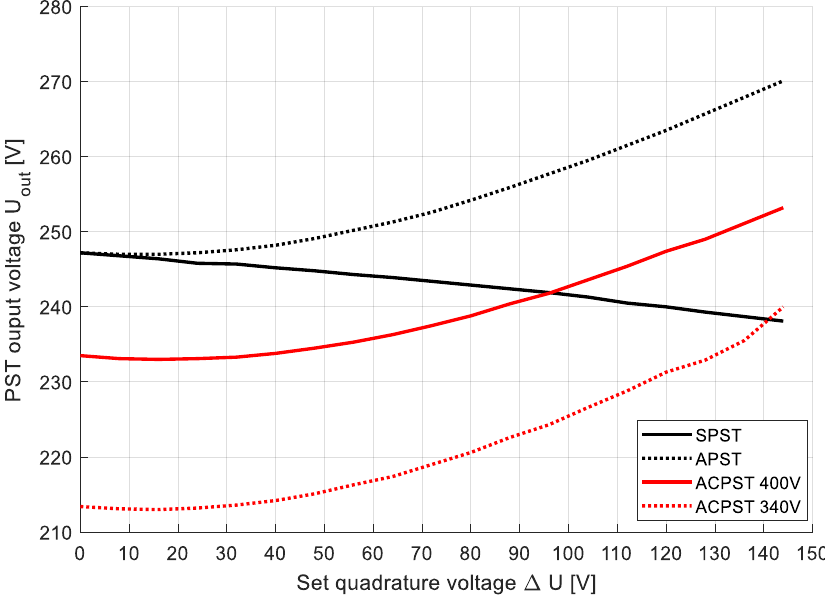
Figure 14. PSTs’ output voltages versus set quadrature voltages. All asymmetrical PSTs have a common feature. While the set quadrature voltage increases, the output voltage also increases. This is a natural consequence of their construc- tion. Opposite to asymmetrical units, the SPST output voltage slightly decreases. This is a consequence of the voltage drops in the system due to greater current for higher quadrature voltages. Additionally, Table 3 collected the system voltage and SPST output voltage as a comparison of its symmetrical operation (both voltages have similar values). The highest set quadrature voltages are visible with the highest differences between analyzed voltages (for 144 V, the voltage drop is equal to 2.6 V). This relation is connected to the increase in the current flow and, consequently, voltage drops. Table 3. Comparison of the system voltage and the SPST output voltage for considered quadrature voltage range.